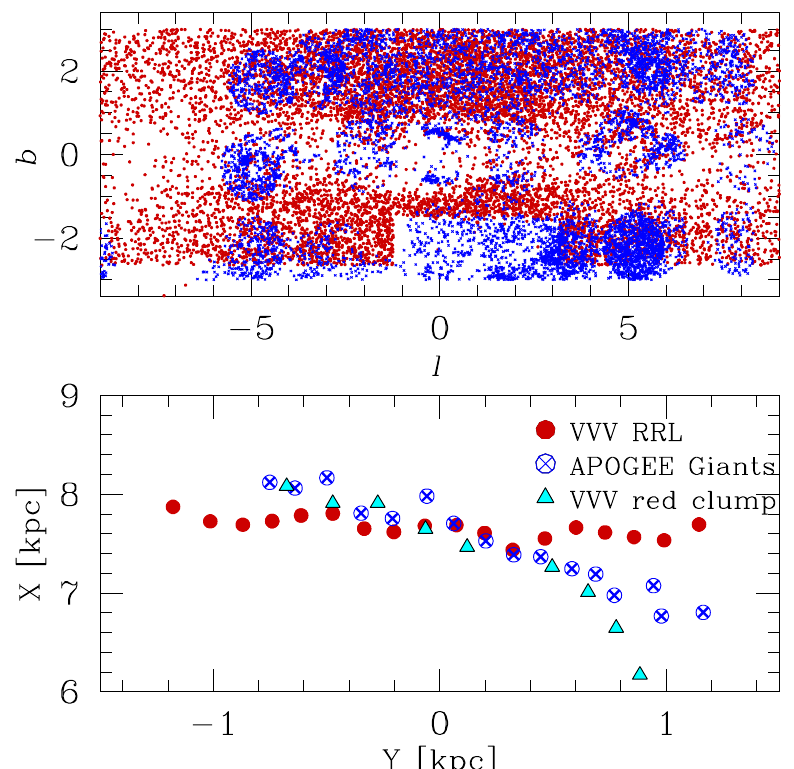
Figure 3. A comparison of the spatial properties of the RRLs in the inner Galaxy (red) compared to the giants in the inner Galaxy (blue). The top panel shows the location in Galactic coordinates of the APOGEE giants (blue) and the VVV RRLs from Dekany and Grebel (2020) [109] (red). The bottom panel shows the mean spatial distribution of these two inner Galaxy stellar traces. The red-clump stars studied in Gonzalez et al. (2012) [98] to trace the bar/bulge are shown as